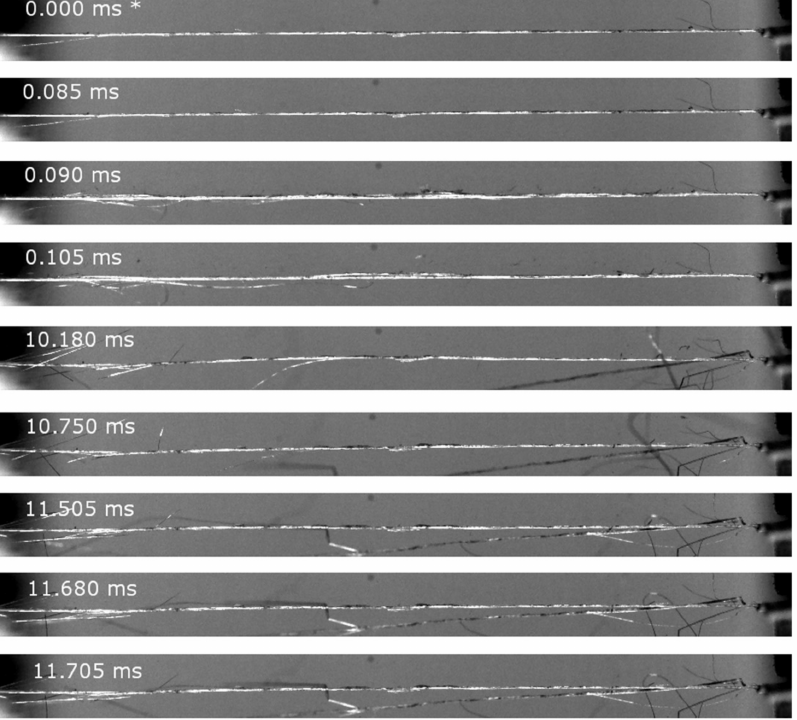
Figure 8. Ultra-high-speed camera observation during tensile tests of flax fibre bundles. *: 0 ms presents the last picture without any visible fibre